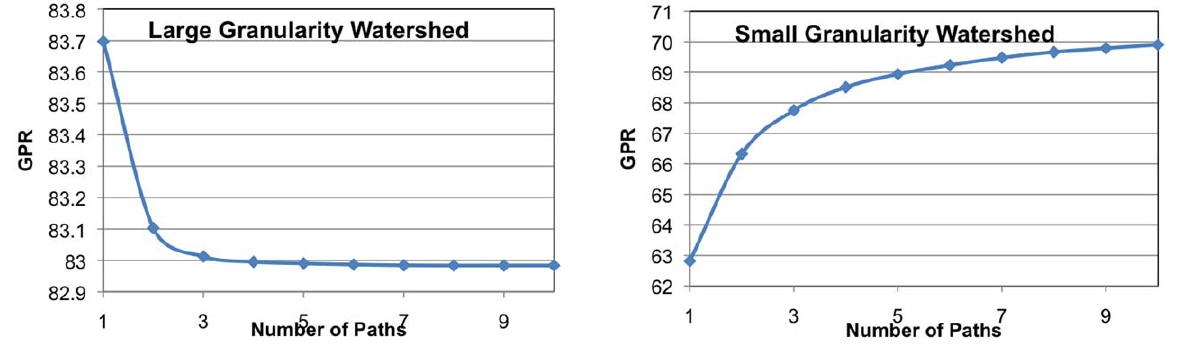
Figure 10. The quality of GPR approximation as a function of the number of paths considered. Note that small magnitude difference between one path and the maximum number of paths.